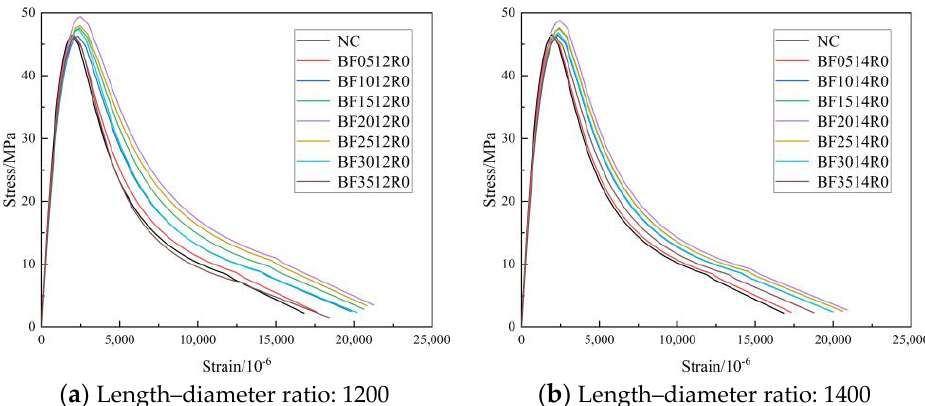
Figure 12. Complete stress-strain curve of BFRC under uniaxial compression.